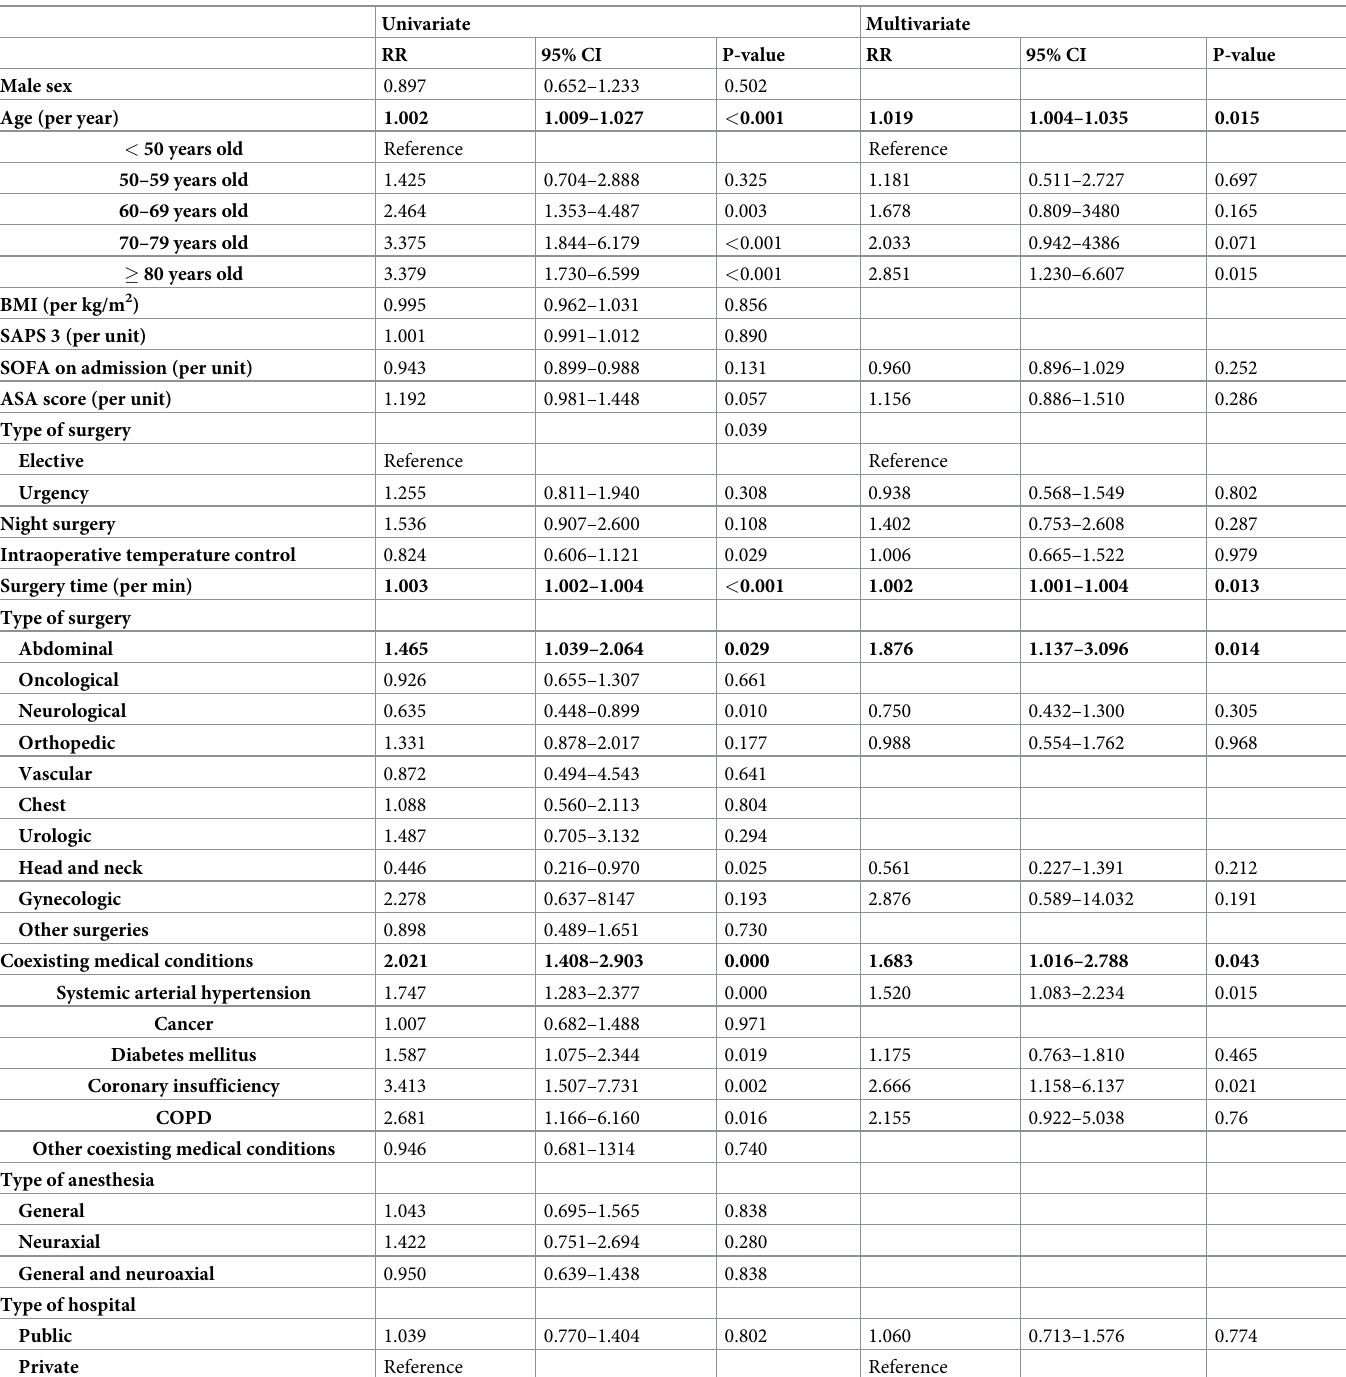
Table 3. Univariate and multivariate analyses of factors related to a postoperative temperature of �